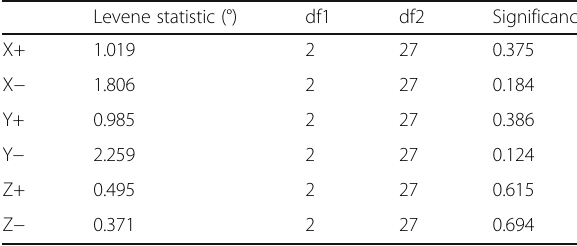
Table 4 Homogeneous test of variance under conditions of different avatar